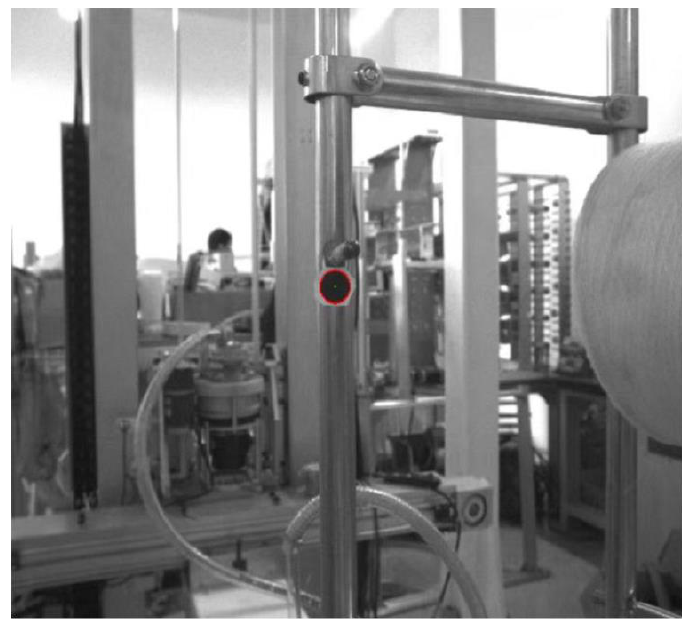
Figure 7. Effect drawing of disc marker recognition.